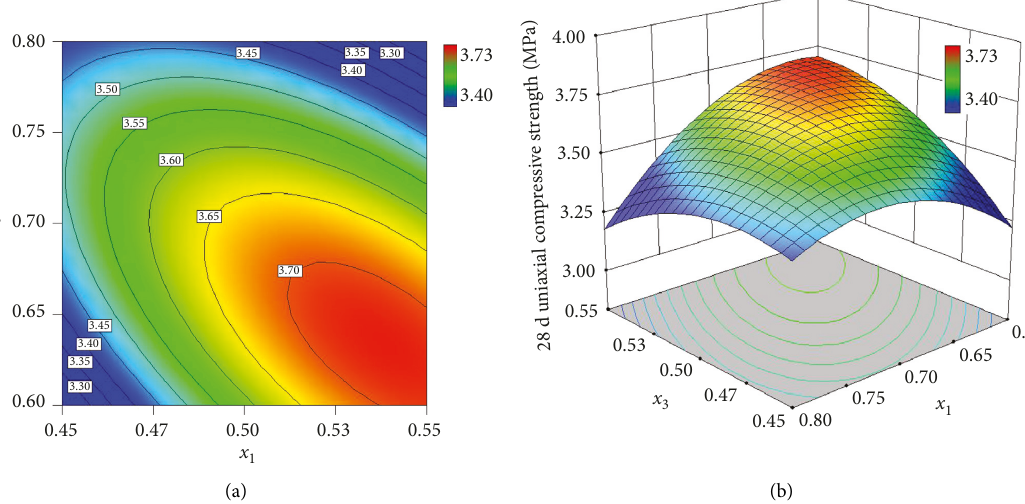
Figure 13: Interaction influence of x 1 and x 3 on 28d compressive strength. (a) Two-dimensional diagram. (b) Three-dimensional